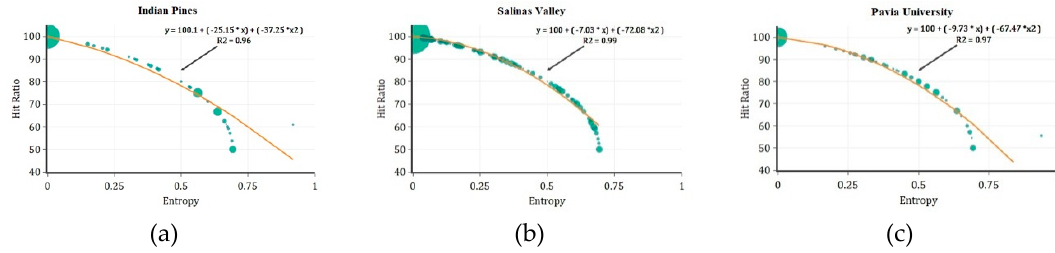
Figure 6. Entropy versus the hit ratio of rules for the ( a ) Indian Pines, ( b ) Salinas Valley and ( c ) Pavia University dataset 10% training sample sizes. The bubble sizes show the frequency of each rule among all corresponding rules from different rule sets before combining votes.